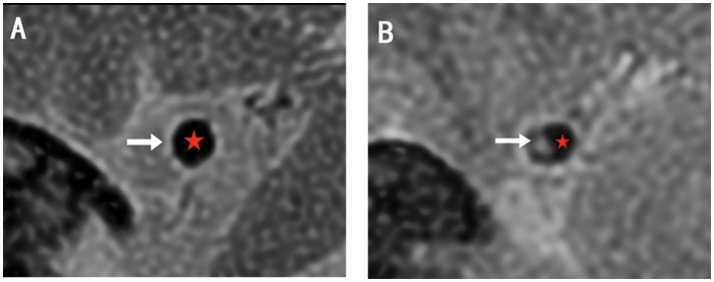
The examples of HRMRI T2WI. (A) The normal lumen shows vessel wall with high signal (white arrow) and smooth lumen with low signal (red star). (B) The lesion site shows plaque with relatively high signal (white arrow) and narrow lumen (red star). The structures are clear and can be divided.